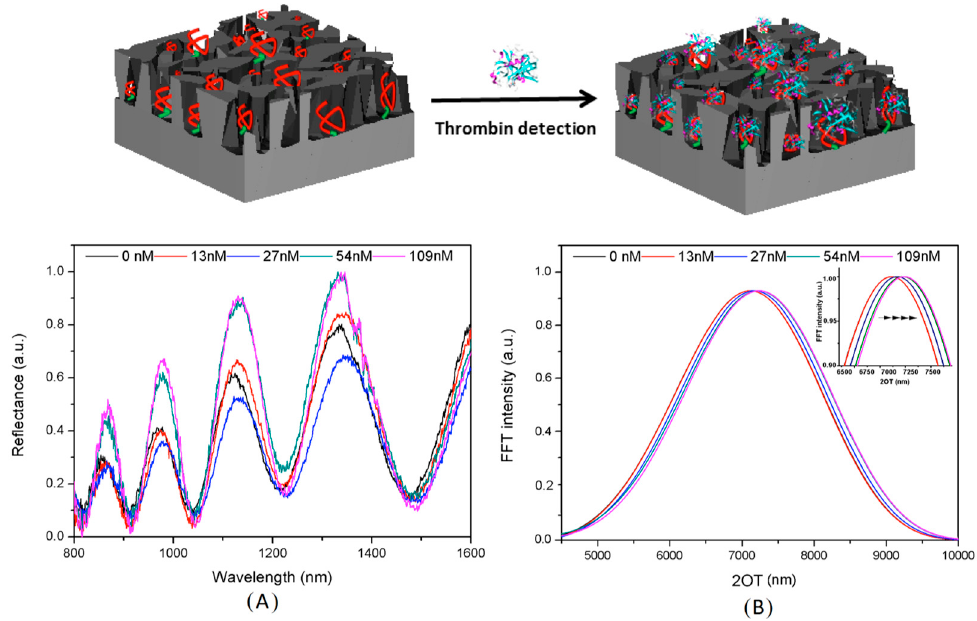
Figure 6. Reflectivity spectra ( A ) and corresponding Fourier transforms ( B ) of PSi-aptasensor after exposure to different thrombin concentrations (13, 27, 54 and 109 nM). Reproduced with permission from [71].